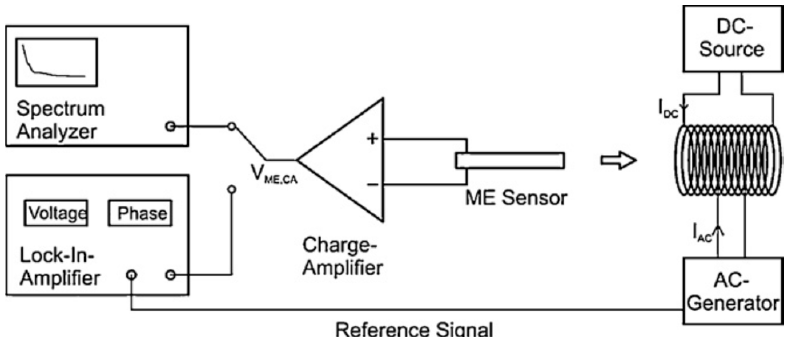
Figure 1. Diagram of the magnetically induced magneto-electric coupling coefficient experiment. The system allows simultaneous application of DC and AC magnetic fields, while electrically induced signals are amplified and detected to determine frequency response via a spectrum analyser or amplitude response via a lock-in amplifier. Refinements such as cryogenic or high temperature measurements and/or simultaneous applied mechanical stress are possible to implement into this generic instrument. Image source: [25].